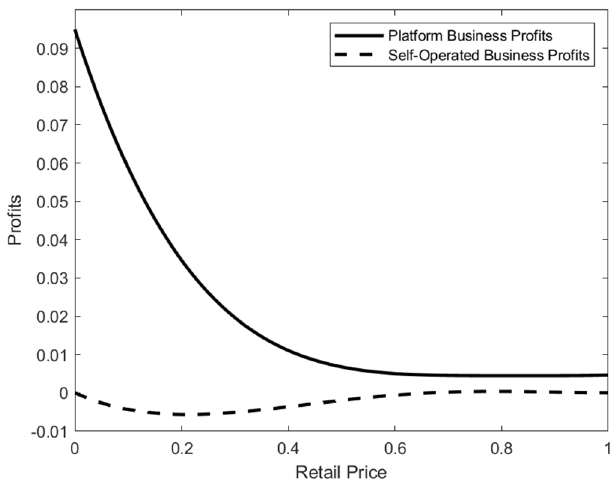
Figure 13. Self-operated business profits and platform business profits in the competition case.